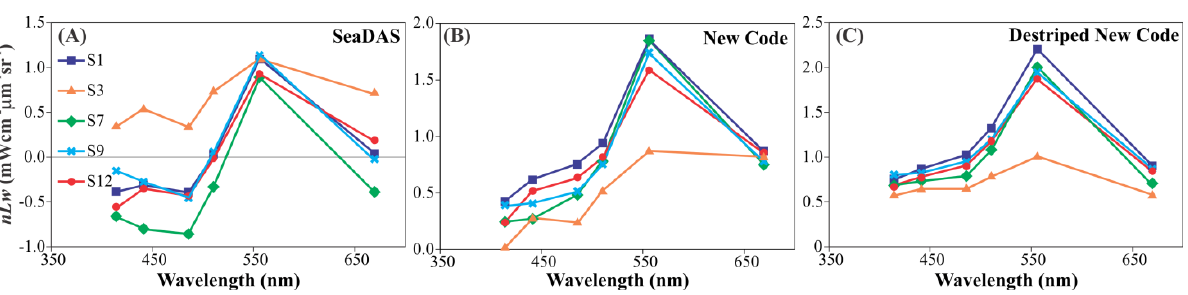
Figure 12. Comparison of normalized water-leaving radiance ( and by the new code before and after destriping of the OCM data of 20 April 2007 at selected 5 sites (S1, S3, S7, S9 and S12) out of the 12 sites in Lac des